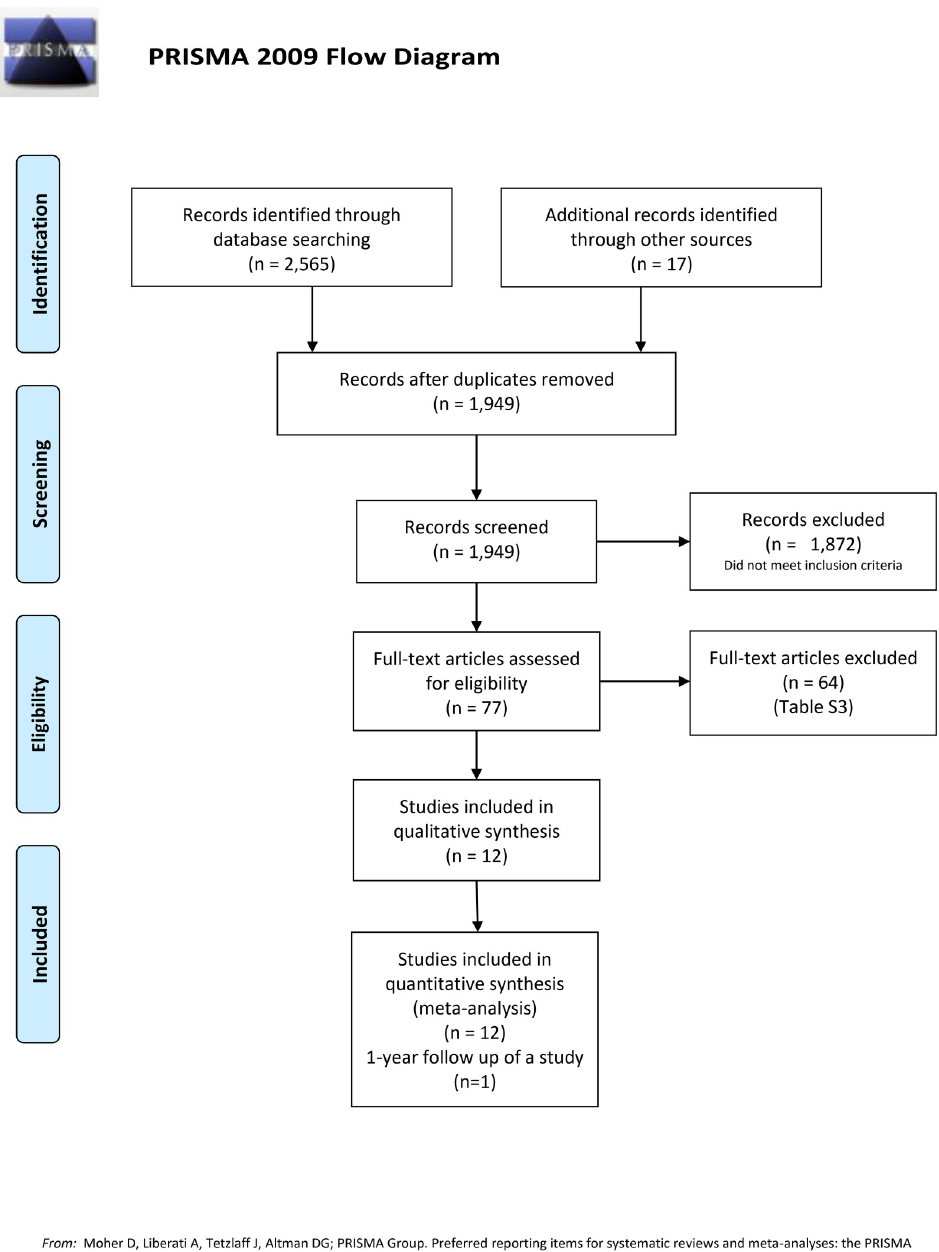
Fig 1. Literature search flow